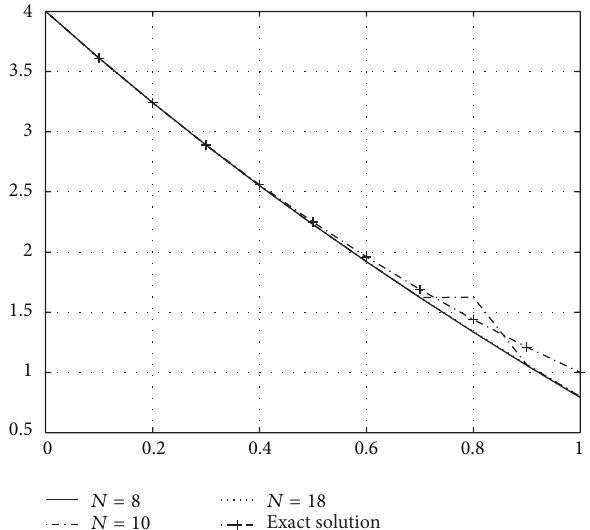
Figure 3: Numerical and exact solution of Example 5 for 𝑁 = 8 , 10,